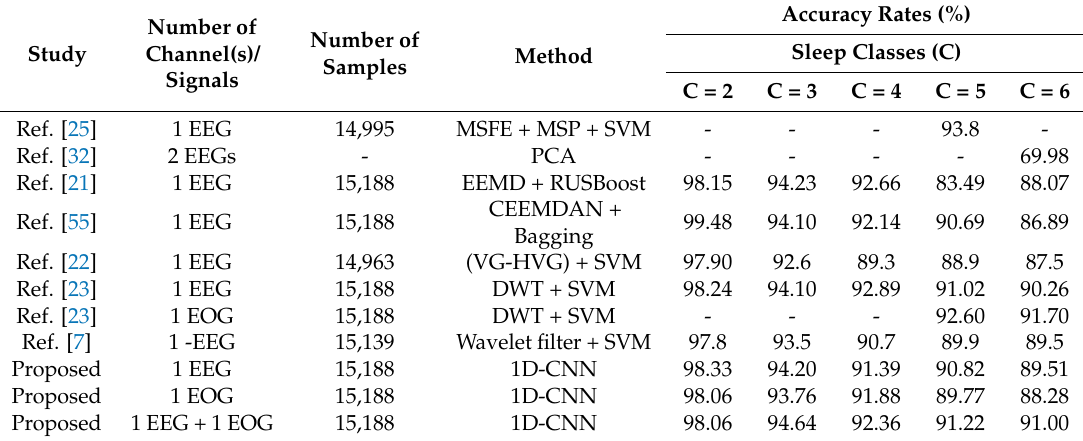
Table 13. Summary of works conducted on the automated classification of sleep classes using the sleep-edf